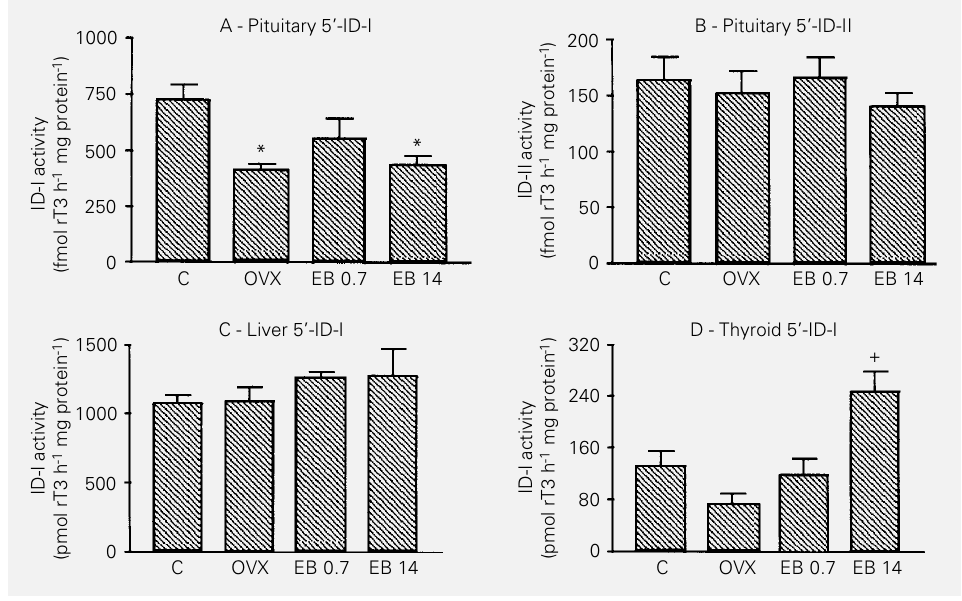
Figure 1 - Type I and II 5’- iodothyronine deiodinase activ- ity in anterior pituitary homoge- nate (panels A and B), and type I 5’-iodothyronine deiodinase ac- tivity in liver and thyroid micro- somes (panels C and D) of fe- male sham-operated control (C) and ovariectomized rats treated with vehicle (OVX) or 0.7 or 14 µg/100 g body weight estradiol benzoate (EB), sc , daily for 10 days. Data are reported as means ± SEM. *P<0.05 vs C; + P<0.05 vs all groups (one-way ANOVA followed by Student- Newman-Keuls multiple com- parison